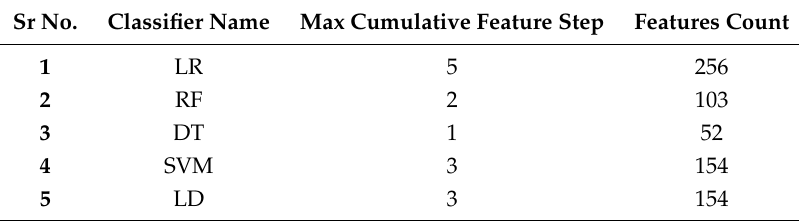
Table 10. Classifiers’ cumulative feature selection step and